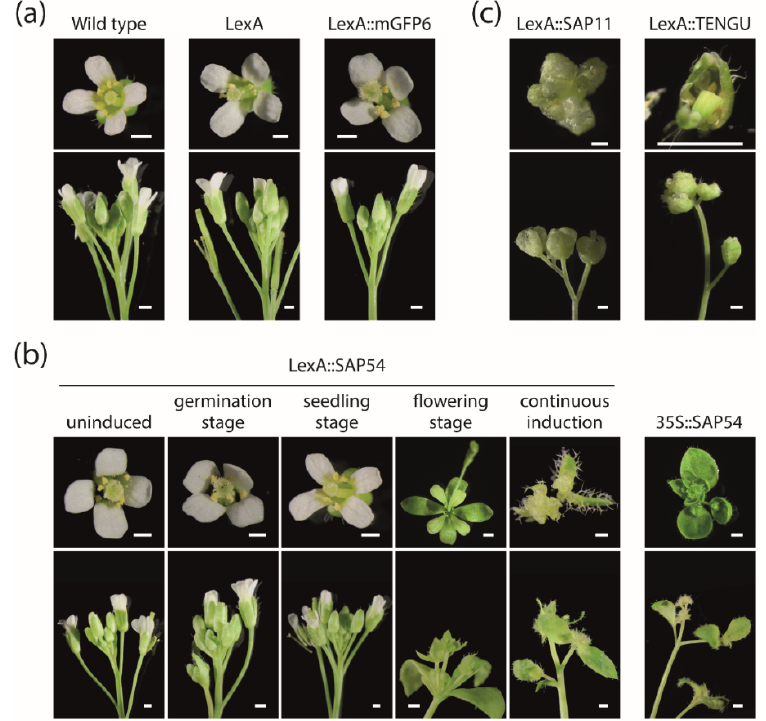
Figure 5. Floral phenotypes observed upon induction of SAP54, SAP11, and TENGU expression in Arabidopsis. ( a ) Flowers (top) and inflorescences (bottom) of Arabidopsis Col-0 wild type plants, LexA empty vector control plants and LexA::mGFP6 plants grown on IM throughout (continu- ous induction). ( b ) Flowers and inflorescences of LexA::SAP54 plants that were either grown on NM throughout (uninduced), induced at germination, seedling or flowering stage, or grown on IM throughout (continuous induction). Flowers of 35S::SAP54 plants are shown for comparison. ( c ) Flowers and inflorescences of LexA::SAP11 and LexA::TENGU plants grown on IM throughout. All images were recorded 28 DAS. Scalebars correspond to 0.5